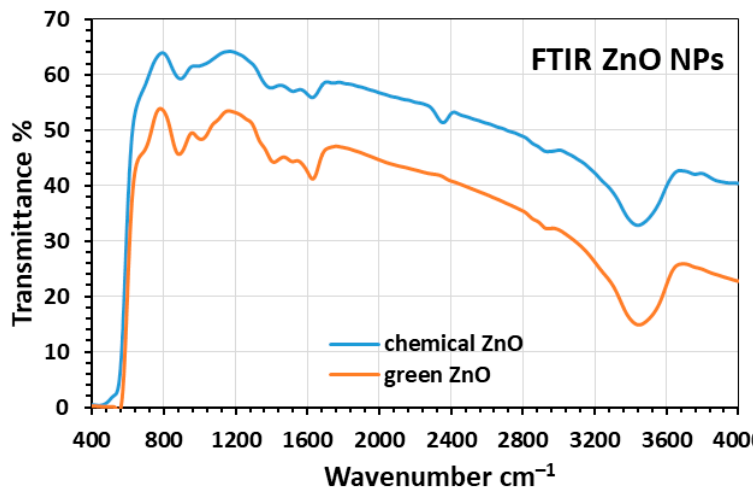
Figure 8. The FTIR spectrum of chemical and green synthesized ZnO NPs.